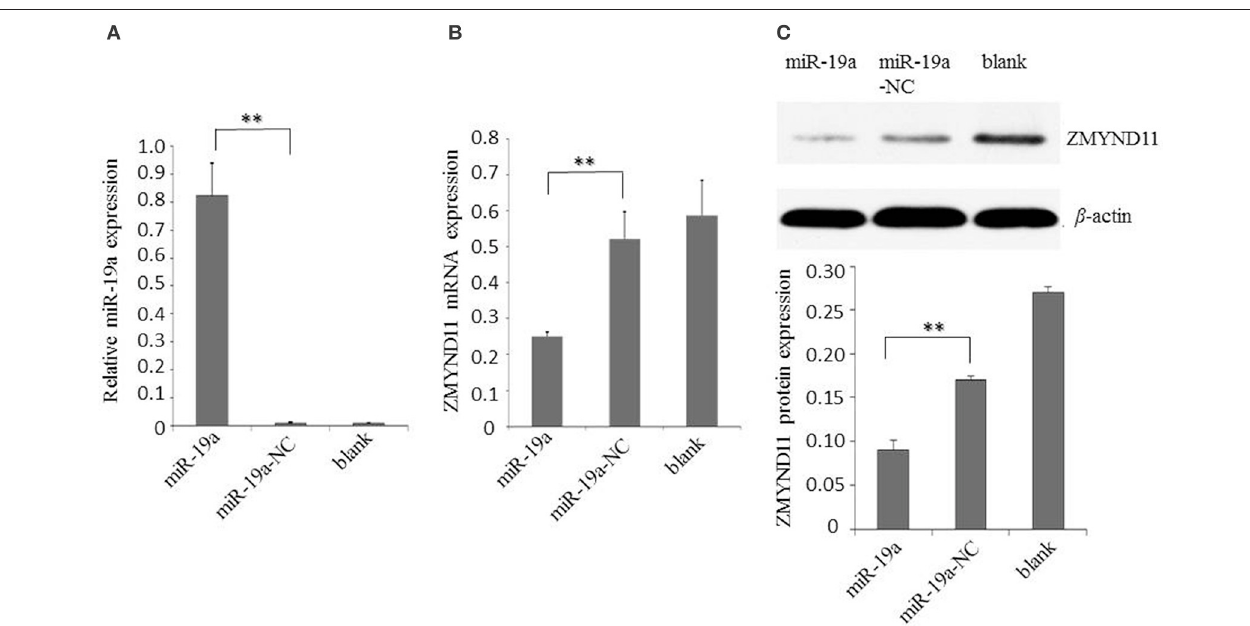
FIGURE 3 | Gga-miR-19a inhibits ZMYND11 expression. (A) Over-expression of gga-miR-19a in DF-1 cells; (B) The level of ZMYND11 mRNA in DF-1 cells over-expressing gga-miR-19a was determined by RT-qPCR; (C) Western blot was performed to analyze ZMYND11 protein expression in DF-1 cells at 48 h post- transfection with gga-miR-19a. A mock transfection was used as the blank. GAPDH was used as an internal quantitative control. All values are represented as the mean ± SD of three independent experiments in triplicate. Significant differences are denoted as ** P <